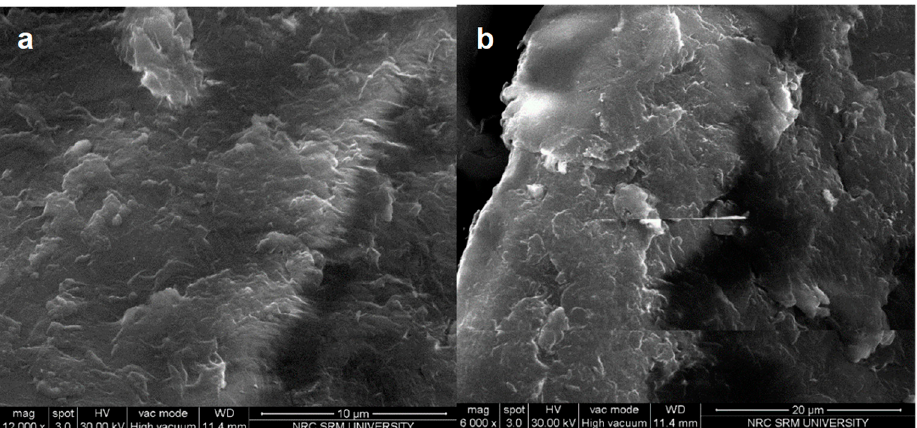
Figure 7. The surface morphology of purified EPS obtained from marine archaea Halococcus sp. AMS12 by SEM analysis. ( a ) EPS observation at 10-micron magnification and ( b ) at 20-micron mag- nification.